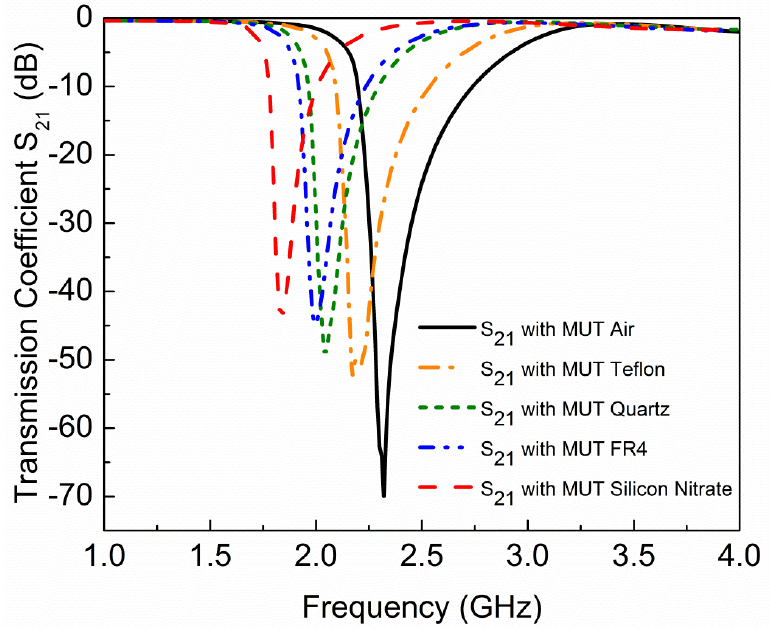
Figure 9. Simulated transmission coe ffi cient S 21 (dB) of sensor due to interaction with di ff erent MUTs. Resonance frequencies of sensors due to interaction with air, teflon, quartz, FR4, and silicon nitrate are 2.32 GHz, 2.17 GHz, 2.04 GHz, 2.0 GHz, and 1.84 GHz,